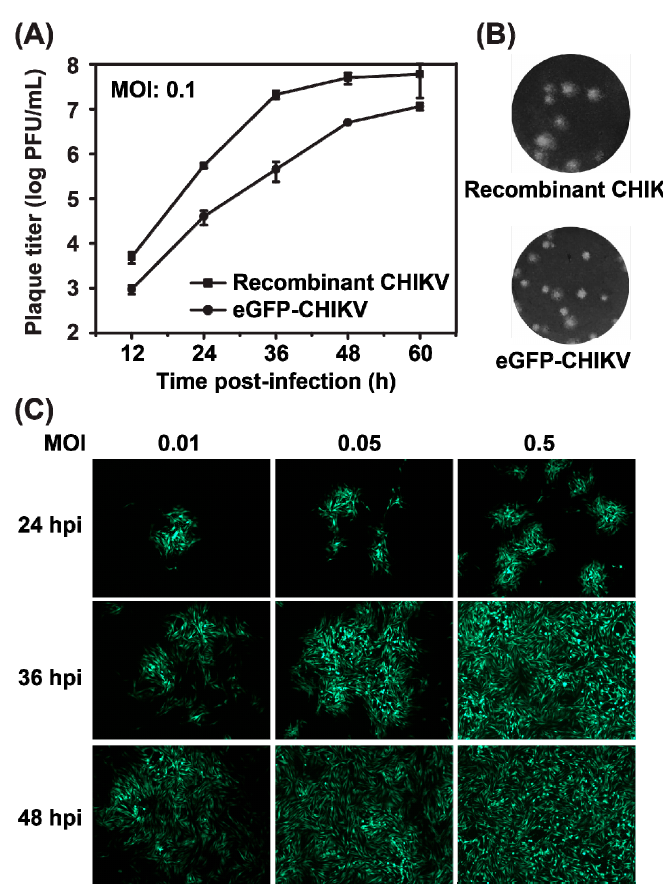
Figure 4. Characterization of eGFP-CHIKV reporter viruses. ( a ) comparison of the growth kinetics of recombinant WT CHIKV and eGFP-CHIKV in BHK-21 cells. The representative data were presented from three independent experiments; ( b ) plaque morphology of recombinant WT CHIKV and eGFP-CHIKV on BHK-21 cells; and ( c ) correlation between eGFP expression and different MOIs infection. BHK-21 cells were infected with eGFP-CHIKV at the indicated MOI and eGFP expression were observed at 24, 36 and 48 hpi.